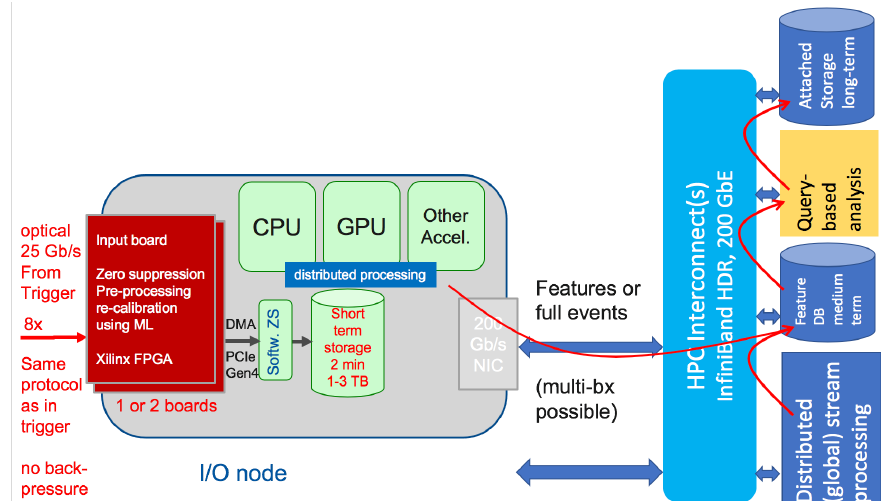
Fig. 2. Data flow in the scouting system I/O node and scouting system. ZS: Zero suppression;